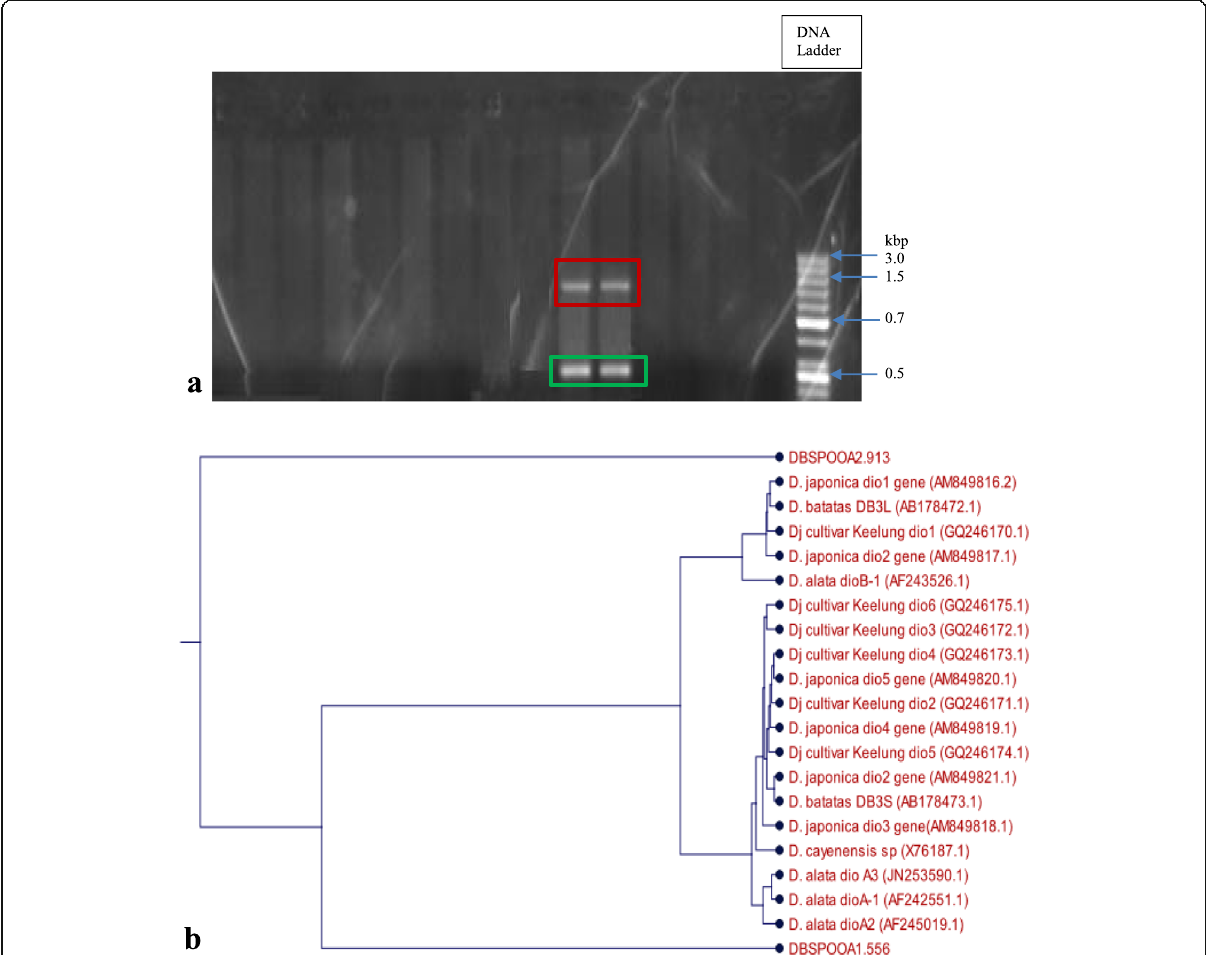
Fig. 6 a PCR amplification of D. bulbifera Dioscorin genes (DBSPOOA) with Dioscorin specific primer set (5 ′ -CTCCTCTCCTCCCTCCTCTT-3 ′ and 5 ′ - GGGGGTACAATGGAGAAGTG-3 ′ ). PCR products were resolved on agarose gels and stained with ethidium bromide. The last lane shows DNA ladder containing DNA fragments of defined length for sizing the bands in the experimental PCRs. The bands outlined in green and red represent DBSPOOA1 and DBSPOOA2, respectively. b Phylogenetic relationship between DBSPOOA genes and other Dioscorin